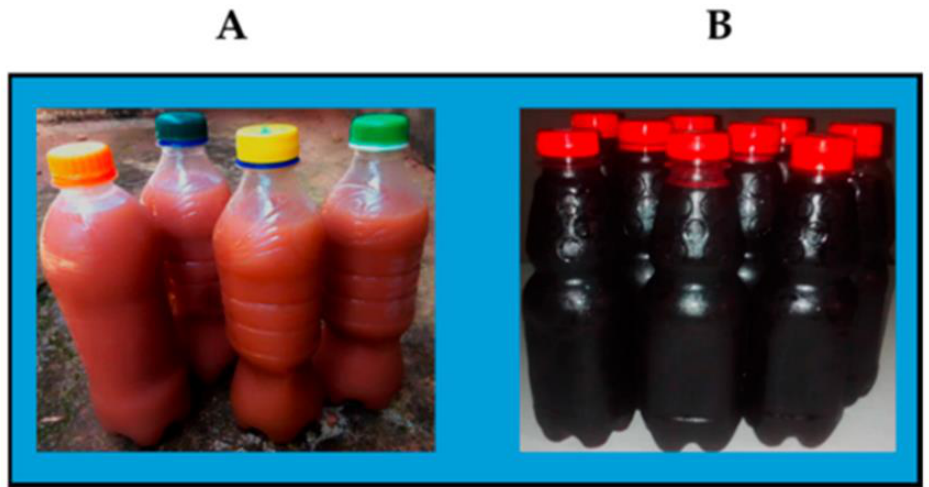
Figure 2. Unregulated drinks sold in many streets in Nigeria. It includes Kunu ( A ) and Zobo ( B ). Source: Nwaiwu et al. [10].